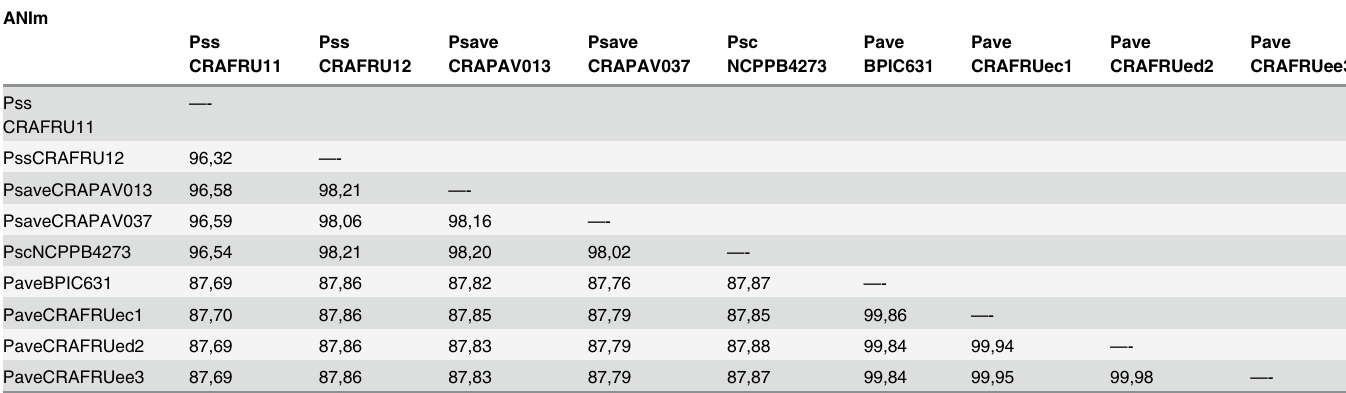
Table 2. Average nucleotide identity (ANIm) values calculated between genomes of nine Pseudomonas strains causing disease to Corylus avel- lana trees (see also Table 3). ANIm